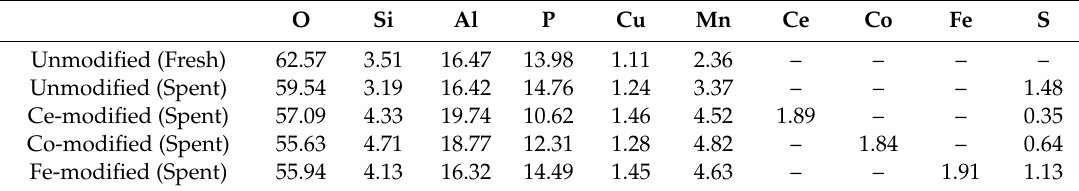
Figure 7. SEM images of several di ff erent catalysts. ( a ) fresh Cu-Mn / SAPO-34; ( b ) SO 2 -poisoned Cu-Mn / SAPO-34; ( c ) SO 2 -poisoned Ce-Cu-Mn / SAPO-34; ( d ) SO 2 -poisoned Co-Cu-Mn / SAPO-34; ( e ) Fe-Cu-Mn / SAPO-34. Table 3. Surface elements of several different catalysts.